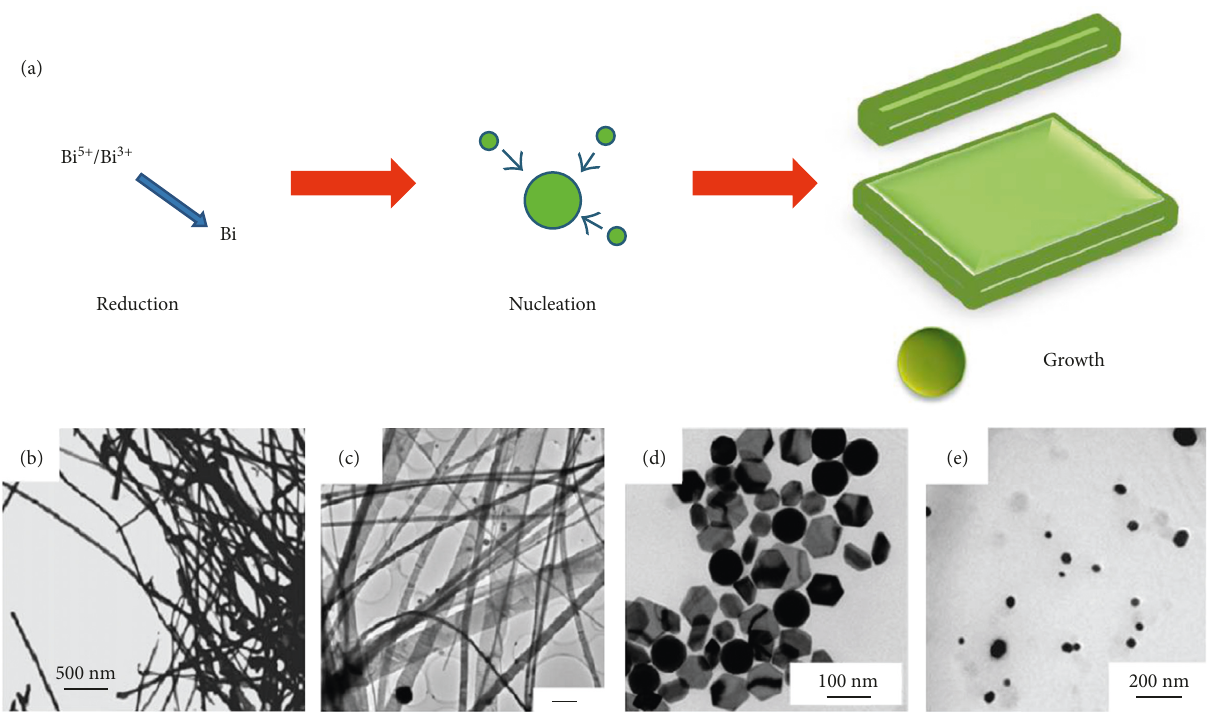
Figure 8: (a) Schematic representation of the Bi nanostructure growth by solution synthesis. TEM image of (b) Bi nanowires [44], (c) Bi nanobelts [73], (d) Bi nanoplates [47], and (e) Bi nanoparticles [52] prepared via solution synthesis, and the scale bar in (c) is 100nm. Reprinted with permission from the American Institute of Physics and American Chemical